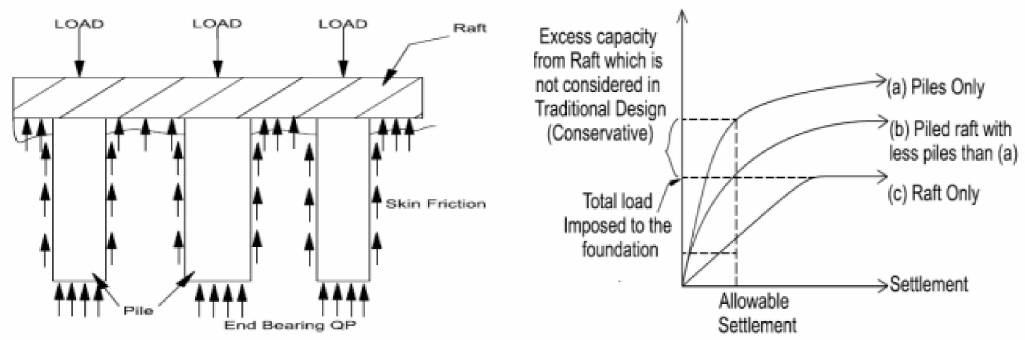
Figure 1. Piled raft foundation (Qp = end bearing capacity of